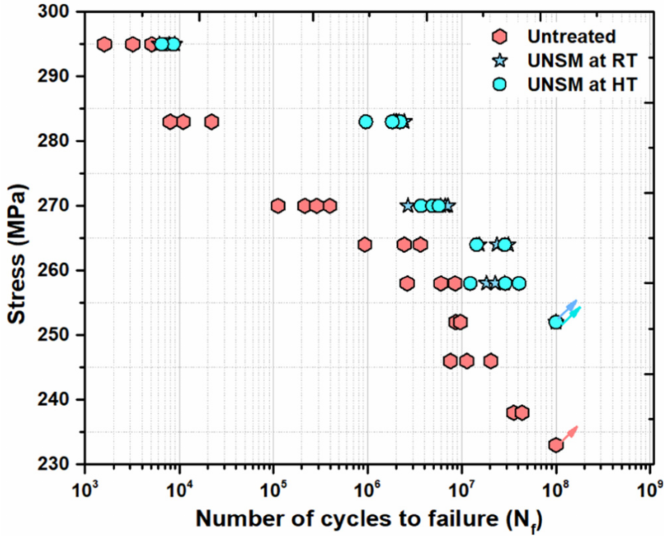
Figure 8. Comparison of UFT test results for the untreated and UNSM-treated at RT and HT